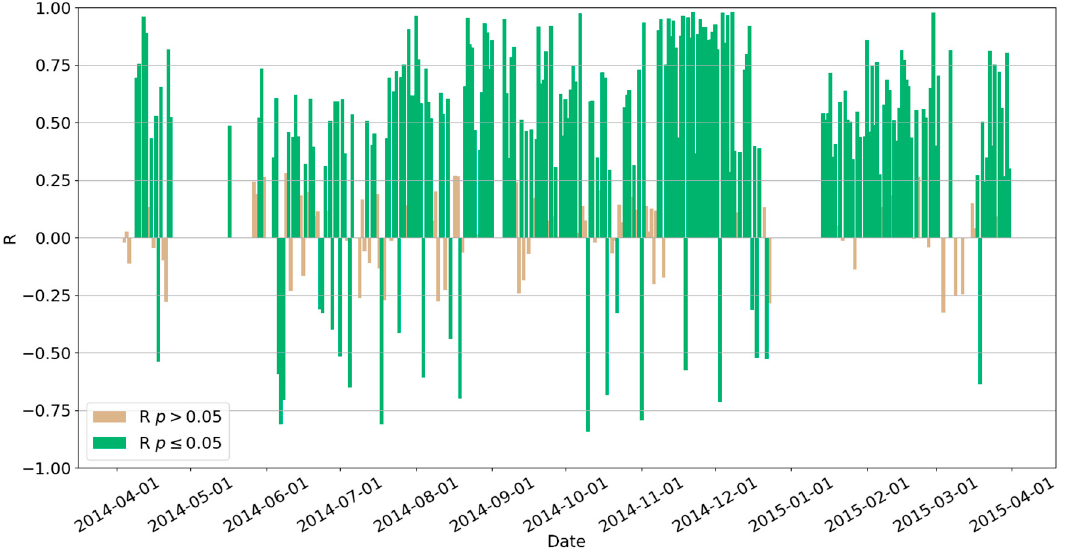
Figure 6. The correlation between daily PRI and LUE for each day from April 2014 to March 2015.